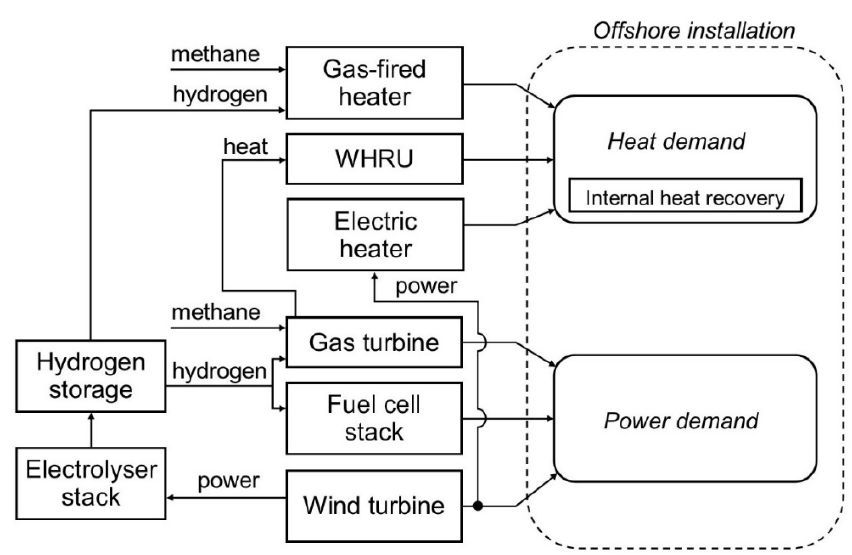
Figure 1. Schematic of the HES-OFF concept with additional heat solutions. The GT simulated is a GE LM2500 + G4 (rated power 33.3 MW), modelled based on